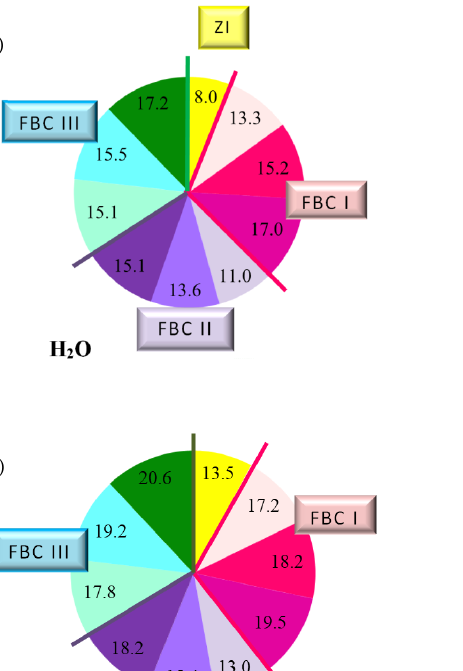
Figure 13. Transformations accompanying the leaching reaction of calcium ions (Ca 2+ ) from ce- ment–ash mortars in the environment of aggressive solutions of acids (HCl, H 2 SO 4 and HNO 3 ) under the influence of the disodium versenate indicator Na 2 H 14 C 10 O 8 N 2 ∙H 2 O. Figure 12. The quantity of leached calcium ions in mortars containing fluidized bed combustion fly ashes of various origins and mixtures composed of FBC fly ashes and conventional fly ashes exposed to the impact of the following environments: reference environment—distilled water H 2 O ( a ) and solutions of acids HCl ( b ), H 2 SO 4 ( c ) and HNO 3 ( d ), expressed in [mg/dm 3 ]. The transformation that accompanied the leaching reaction of calcium ions (Ca 2+ )